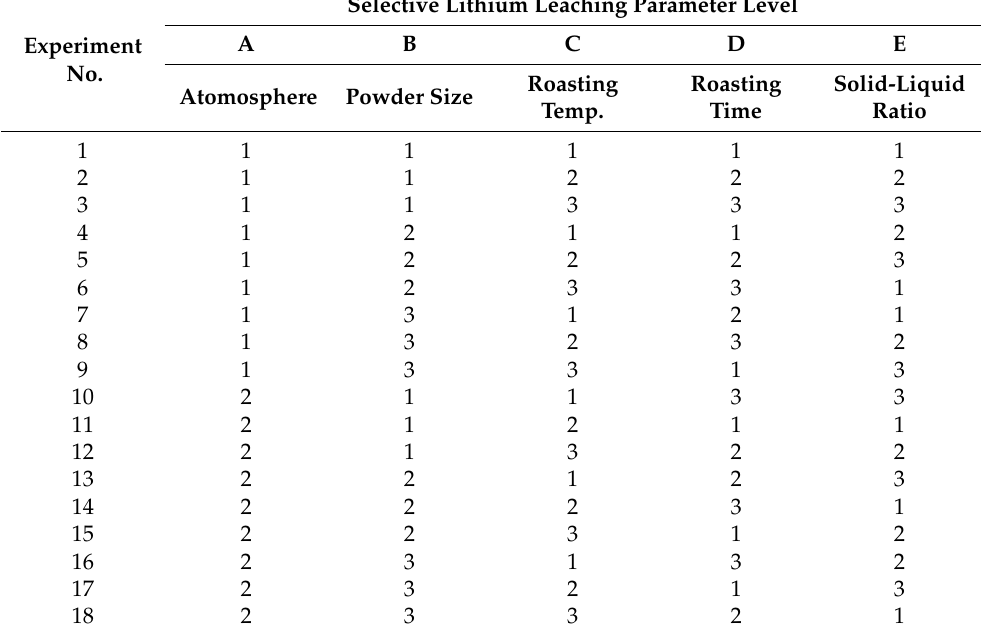
Table 3. Experimental layout using an L 18 orthogonal